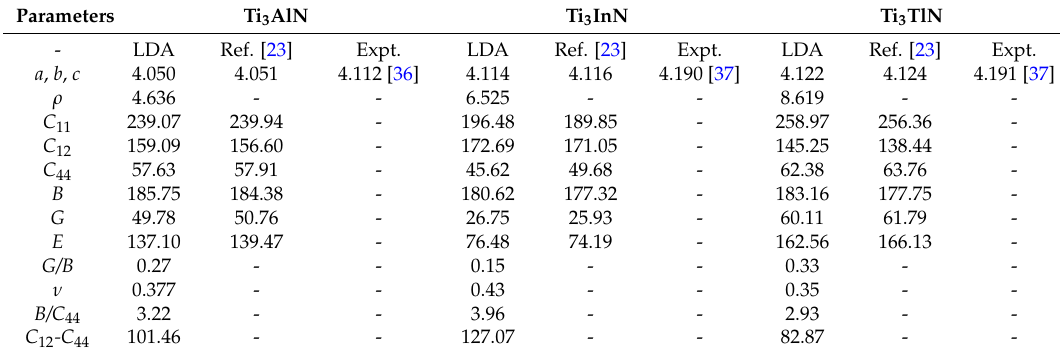
Table 1. Calculated lattice constants a /Å, density ρ /g · cm − 3 , elastic constants C ij /GPa, bulk modulus B /GPa, shear modulus G /GPa, G/B , Young’s modulus E /GPa, Poisson’s ratio ν , B/C 44 and C 12 -C 44